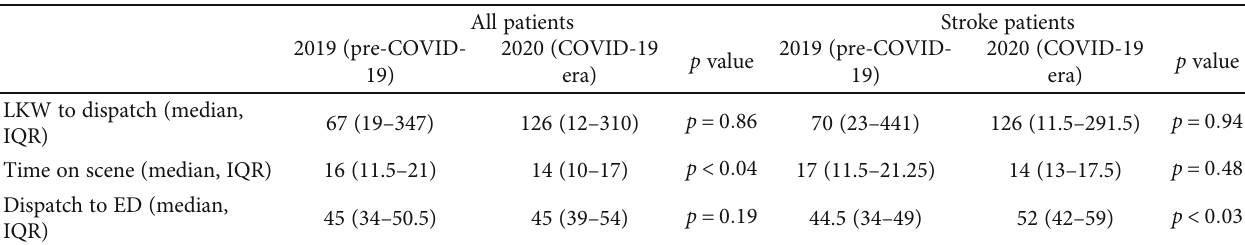
Table 2: EMS time parameters for all patients and patients with a fi nal diagnosis of